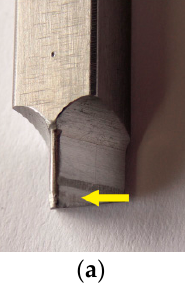
Figure 21. Tool after blanking 60,000 elements with 15% clearance: ( a ) the blanking part of the punch; ( b ) flank wear.